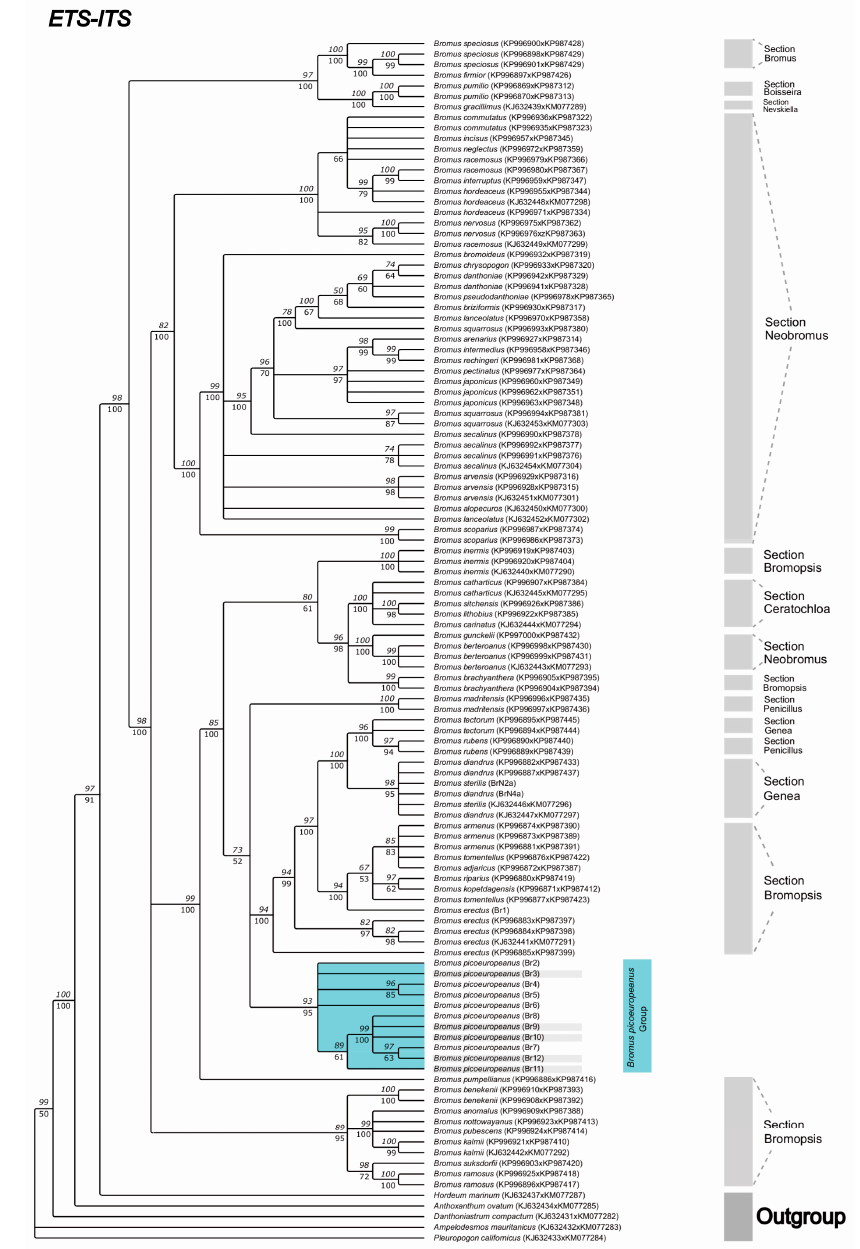
Figure 4. Consensus phylogenetic tree was obtained from ML and BI analyses based on the combination of the nuclear sequences ETS-ITS. The numbers over the branches correspond to the bootstrap (BS) values from the ML analysis, whereas the numbers under the branches represent the posterior probabilities (PP) obtained during the BI analysis. Br: new Bromus samples were generated in this study. The Br samples from the Cantabrian Mountains and from Picos de Europa have been highlighted in blue. The Br sample from lower lands has been highlighted in gray.